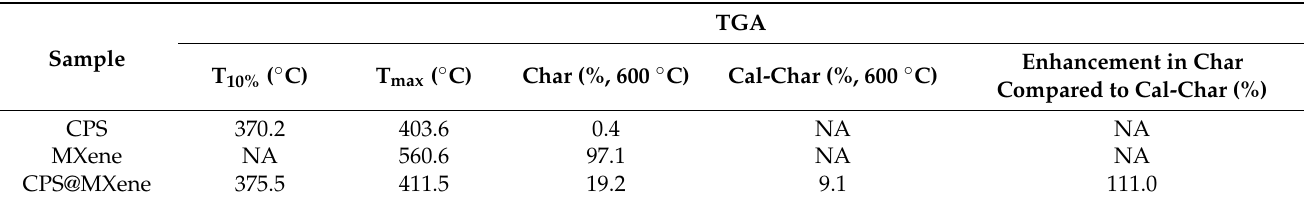
Figure 2. ( a ) TGA curves of MXene, CPS, and CPS@MXene. MXene and HSMX characterized by ( b ) FTIR, ( c ) XRD patterns, and ( d ) plots of MIP cumulative intrusion versus pressure. Table 1. Thermal properties of CPS@MXene spheres under nitrogen flow.